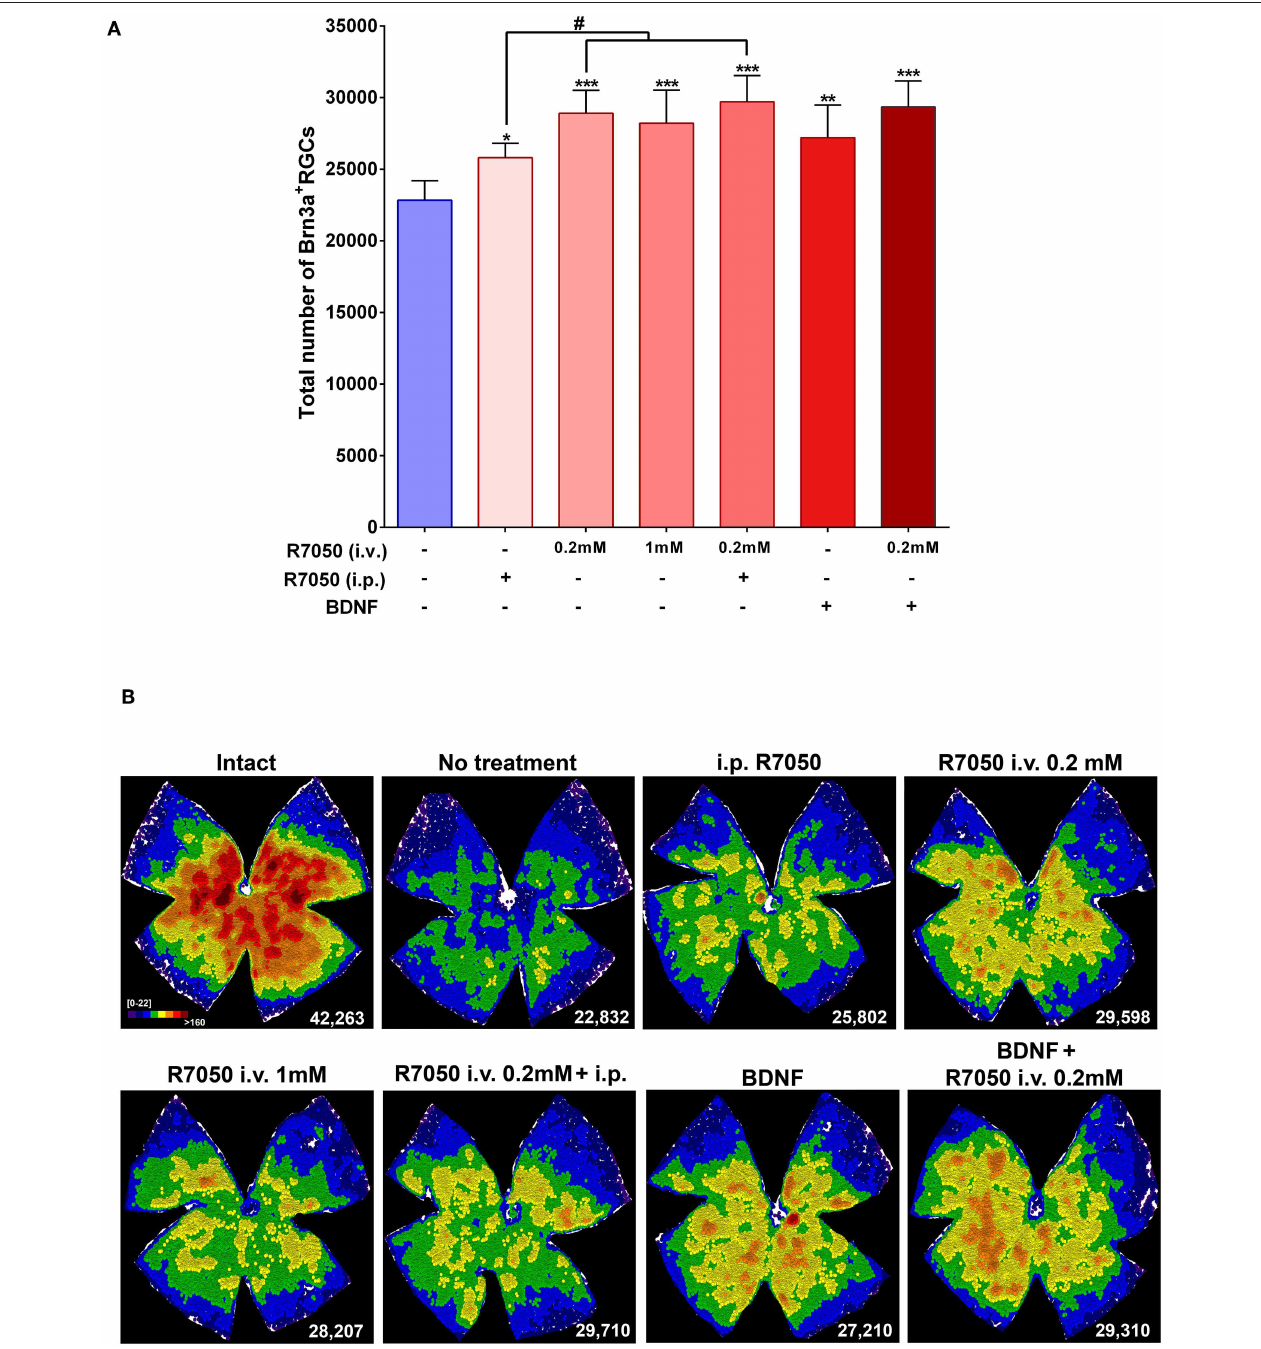
FIGURE 3 | Systemic and intravitreal treatment with R7050 alone or in combination with BDNF rescues RGCs during the quick phase of death after optic nerve axotomy. (A) Column bar graph showing the total mean number ± standard deviation of RGCs quantified in the different animal groups analyzed 5 days after ONC. *Statistically different from ONC alone (* p < 0.05; ** p < 0.01; *** p < 0.001. ANOVA, Kruskal-Wallis. Dunn’s post-hoc test). # p < 0.01 ( T -test). For detailed statistics see Table 1 . (B) Neighbor maps showing the distribution of RGCs in a representative retina from each group and treatment. These maps illustrate the number of RGCs around a given RGC in a radius of 0.200mm with a color scale (top left panel) from 0 to 22 neighbors (purple) to > 160 neighbors (dark red). At the bottom left of each map is shown the number of RGCs counted in the original retina.